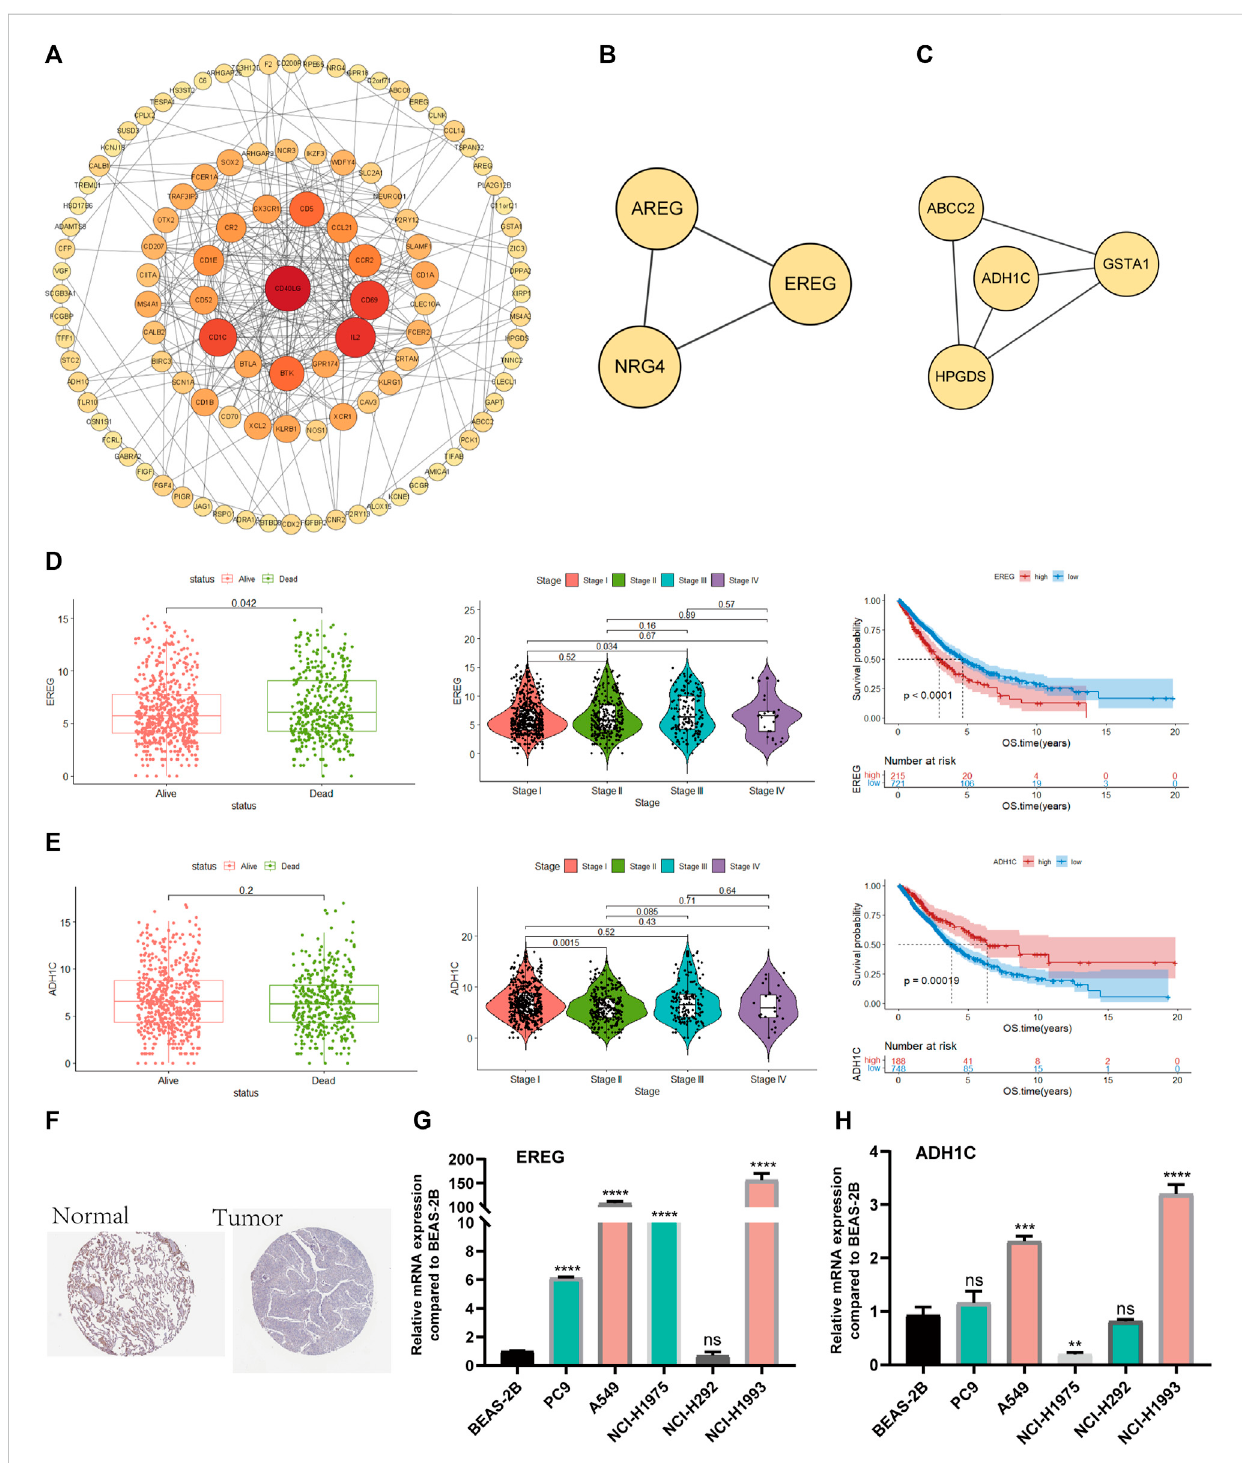
FIGURE 10 Screening and validation of hub genes (A) . PPI network among prognosticgenes. (B, C) Twomodulescontained many genes inthePPI network (D) . The relationship between survival state, stage and mRNA expression levels of EREG, Kaplan – Meier curves of EREG in OS (E) . The relationship between survival state, stage and mRNA expression levels of ADH1C, Kaplan – Meier curves of ADH1C in OS (F) . ADH1C protein levels in normal lung and NSCLC werevisualizedbyIHCinHPA. (G,H) Quantitativereal-timePCRanalysisofthemRNAexpression levelsofEREG andADH1CinNSCLCcelllinesand normal lung epithelial